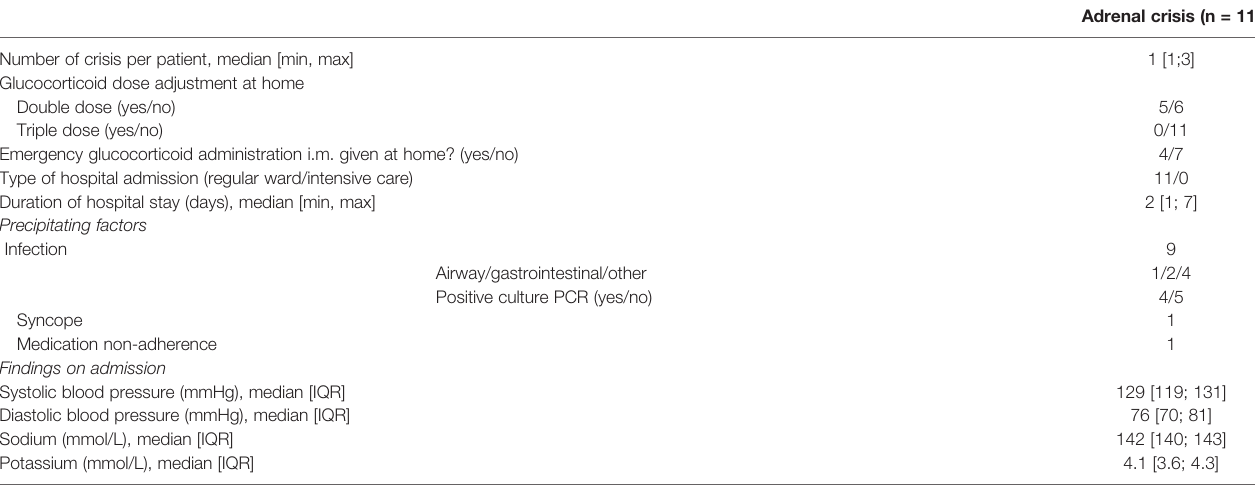
TABLE 2 | Adrenal crisis